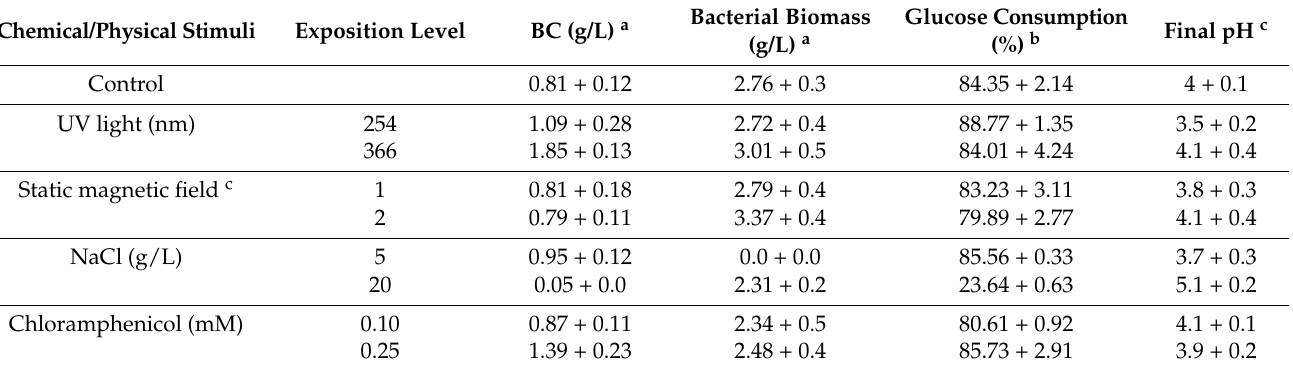
Table 1. BC produced by K. xylinus exposed to physical and chemical stimuli for 12 days in static culture. Chemical/Physical